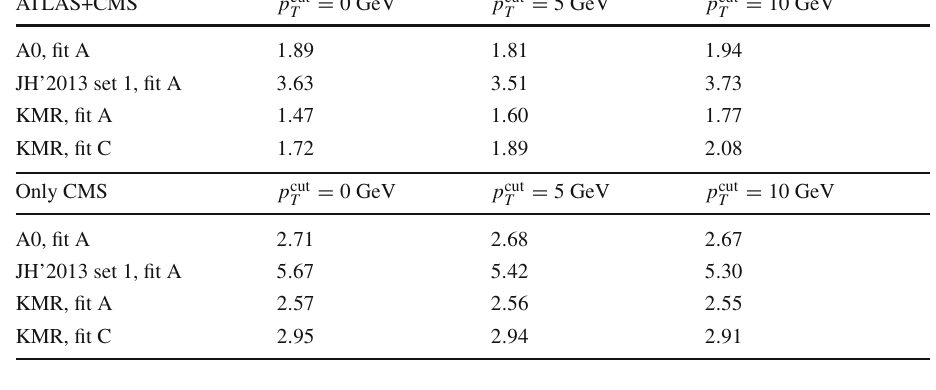
Table 4 The dependence of χ 2 / d . o . f . achieved in the fit procedure (using NMEs from the “fit A” and “fit C” scenarios) on the choice of p cut for only T the ATLAS data and the ATLAS and CMS data combined